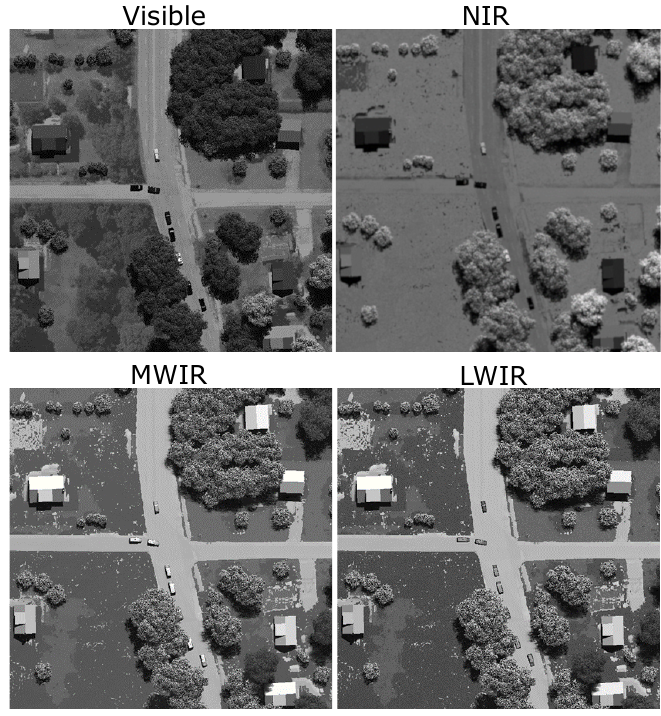
Figure 12. Example multi-spectral images frames from the synthetic DIRSIG data